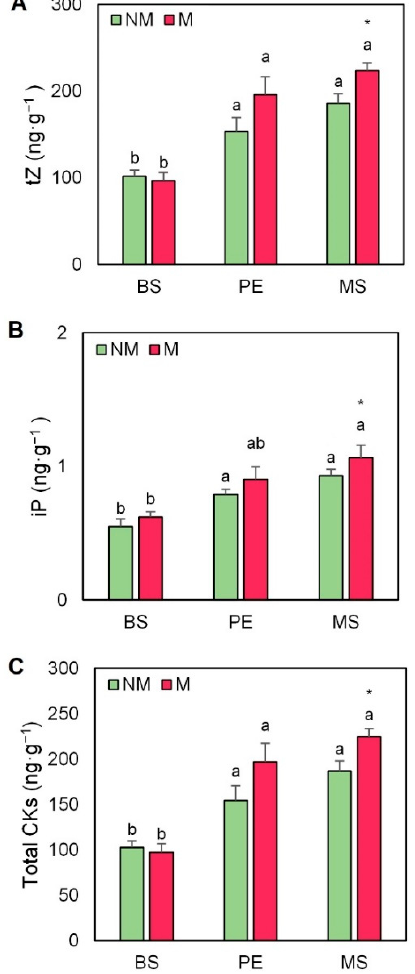
Figure 6. ( A ) Trans-zeatin (tZ), ( B ) isopentenyladenine (iP), and ( C ) total cytokinin (CKs) concentra- tions in leaves of escarole plants of the commercial variety “Bekele” cultivated under non-mycorrhizal (NM) and mycorrhizal (M) conditions and covered or not with mulching treatments. Bars show the means of five plants ± standard error. Different letters show significant differences among mulching treatments while the asterisk (*) indicates significant differences due to AMF inoculation within each mulching treatment according to Tukey’s and t -tests ( p ≤ 0.05). Abbreviations used: bare soil (BS), polyethylene mulch (PE), and mushroom substrate-based hydromulch